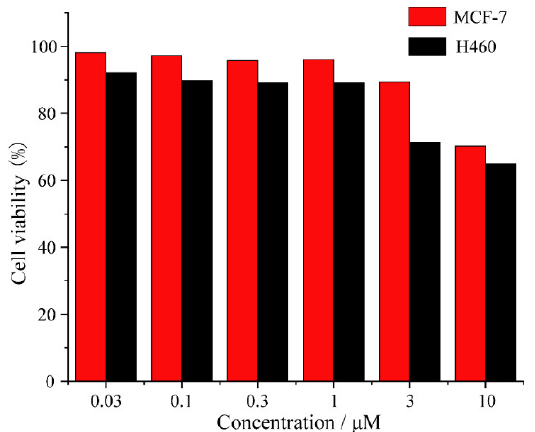
Figure 5. Cytotoxicity assays of MCF-7 and H460 cells incubated with different concentrations of 1 (0.03–10 μM).